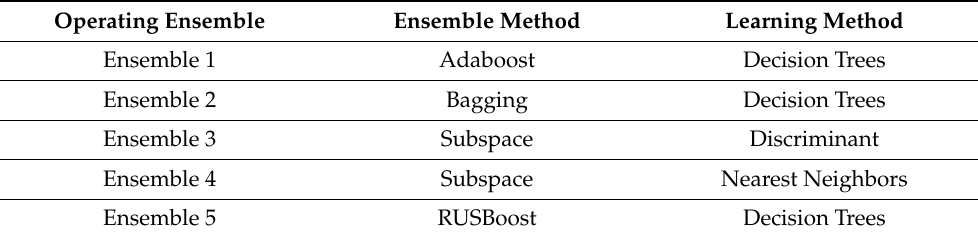
Table 2. Preset values and methods in the experiments for an ensemble